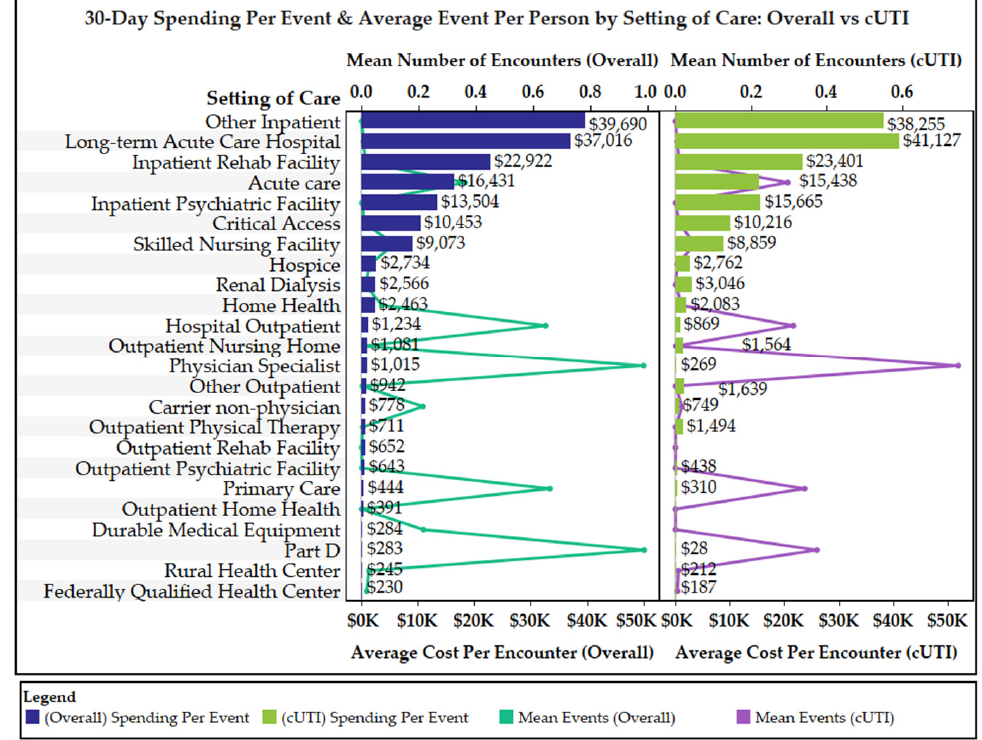
Figure 2. Mean number of overall and cUTI-related 30-day encounters per beneficiary in each service category and average 30-day Medicare spending per encounter in each service category.